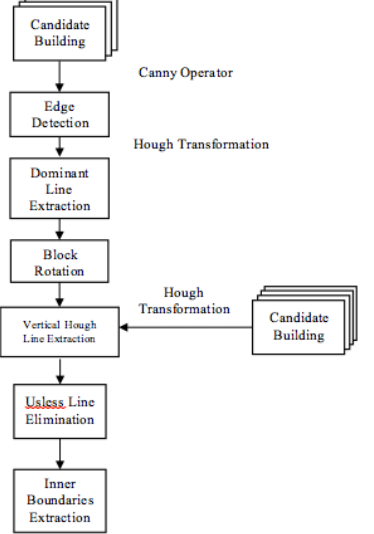
Figure 2. Workflow of Extraction of adjacent footprints in building block based on Hough transformation